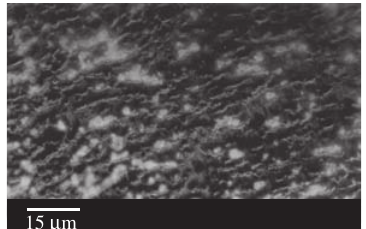
Table 1. Average size of P. fluorescens attached to Au substrates.